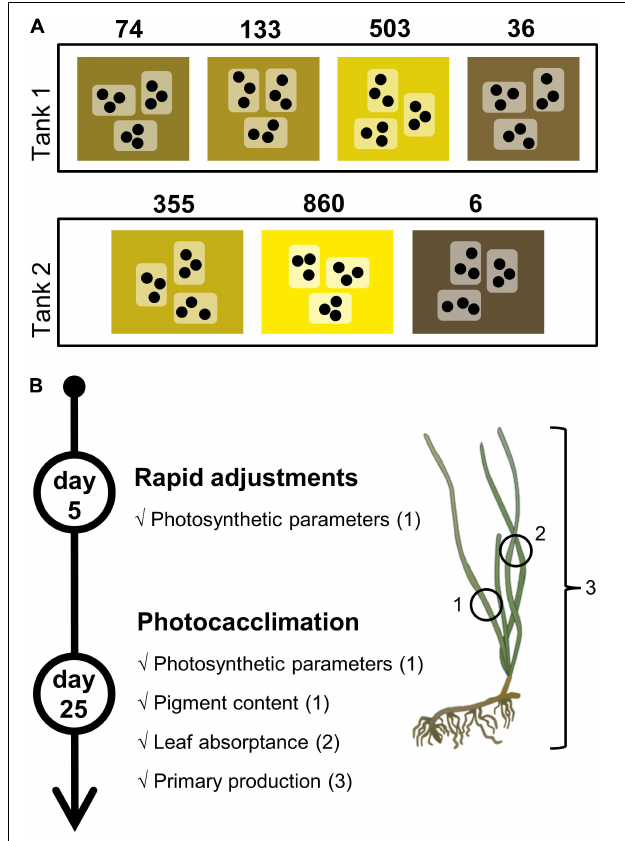
FIGURE 1 | Schematic representation of the experimental system and sampling design. (A) Experimental flowthrough system with the two tanks in which were randomly assigned the seven light intensity treatments (numbers in µ mol photons m − 2 s − 1 ), to which nine shoots